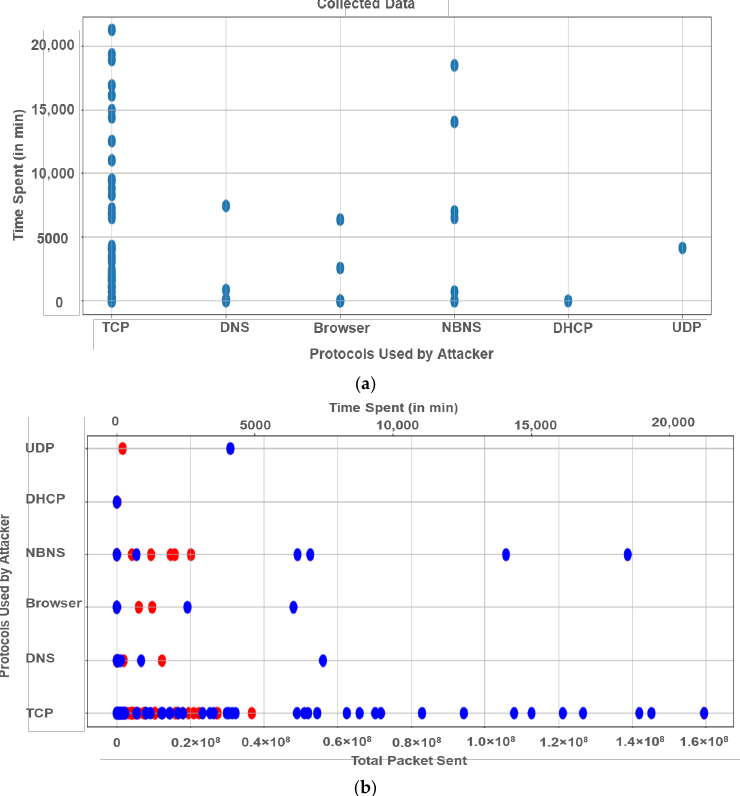
Figure 10. Histogram for ( a ) Time Spent vs. Protocol used by Attackers, ( b ) Protocol used by Attackers vs. Total Packets sent.